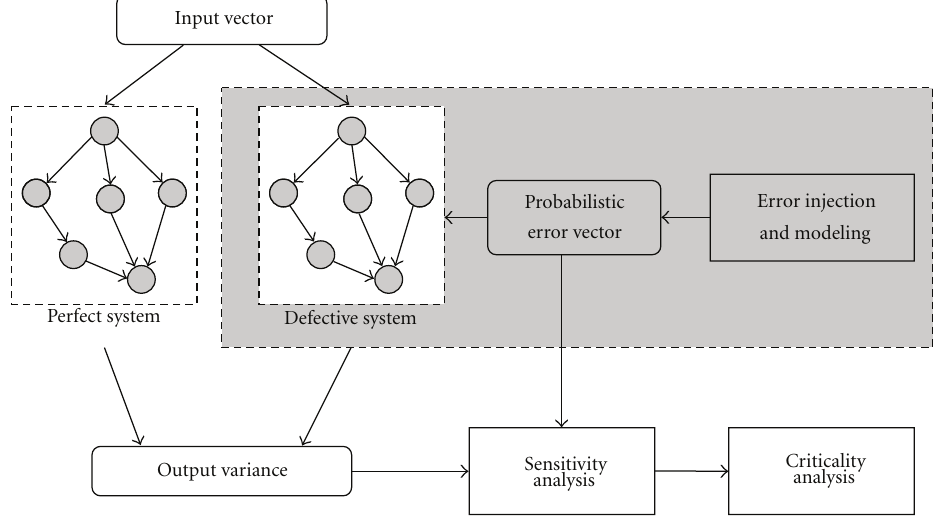
Figure 6: Flow chart of criticality